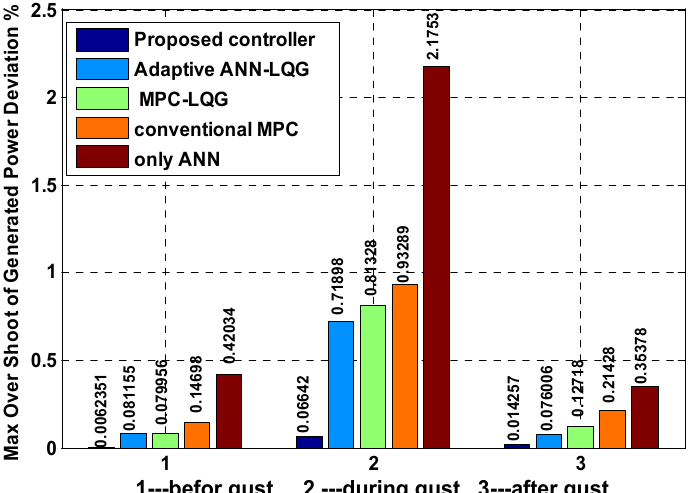
Figure 12. Max overshoot in generation power at different operating modes.